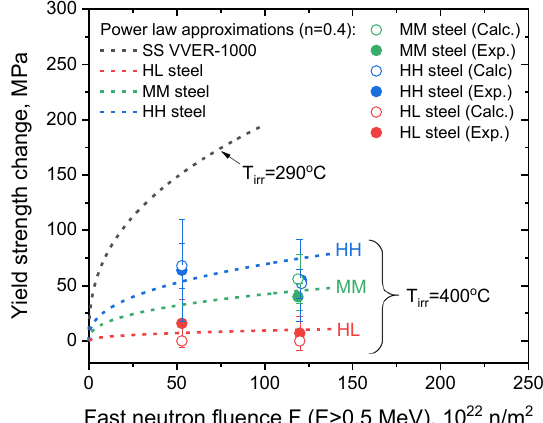
Figure 7. Experimental (filled symbols) and calculated (open symbols) yield strength shifts for the studied steels and for SS VVER-1000 [6] (dashed lines show power law approximations with the degree index n = 0.4).